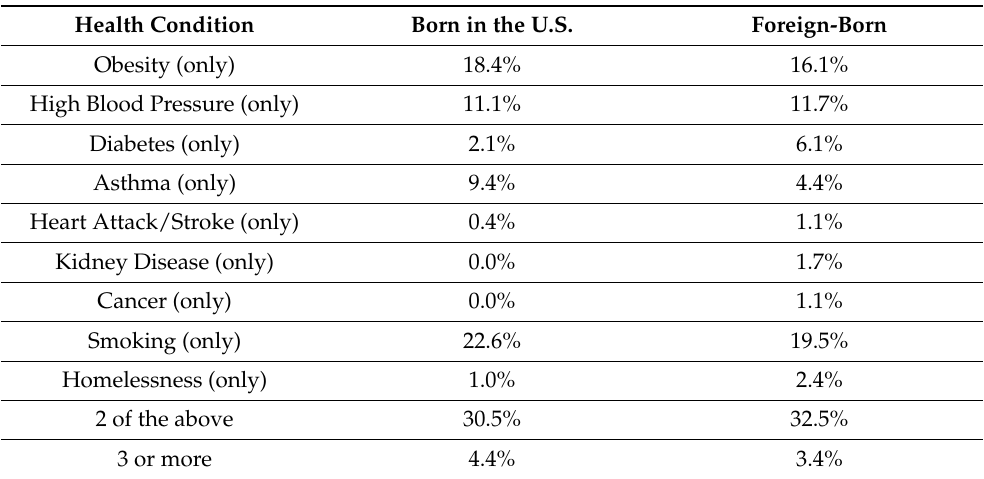
Table 10. Pre-Existing Health Conditions Associated with High Risk of Severe Illness Related to COVID-19, According to Birthplace. Health Condition Born in the U.S.